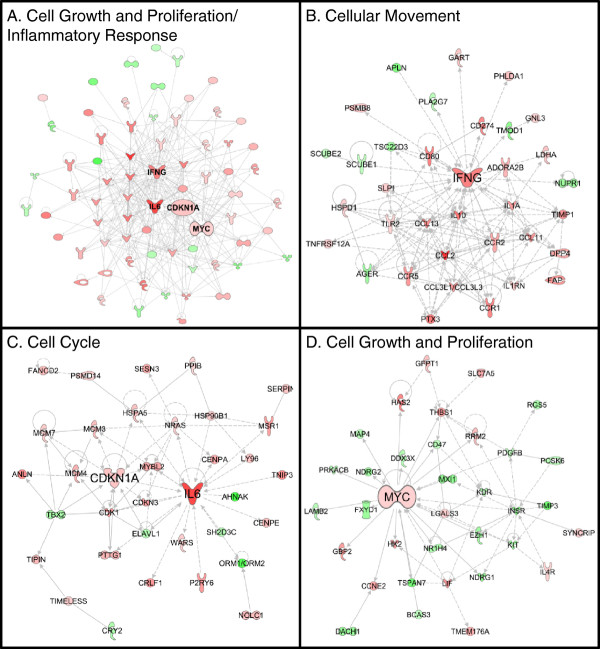
Protein-protein interaction subnetworks differentially regulated in CA04-infected lung tissue. IPA was used to determine subnetworks within the human PPI which were highly populated with genes differentially expressed in CA04-infected tissue on day 7 p.i. We show the top networks (based on their network score) when (A) up to 70 proteins are allowed in the subnetwork and (B-D) the top 3 networks when the size of the subnetwork is limited to 35 proteins. Each network is labeled according to its most enriched biological function. Proteins that’s transcript is up-regulated or down-regulated in CA04-infected lung relative to KUTK4-infected lung are colored red and green, respectively. Additional file 9 provides a larger illustration of panel A with all protein labels shown.